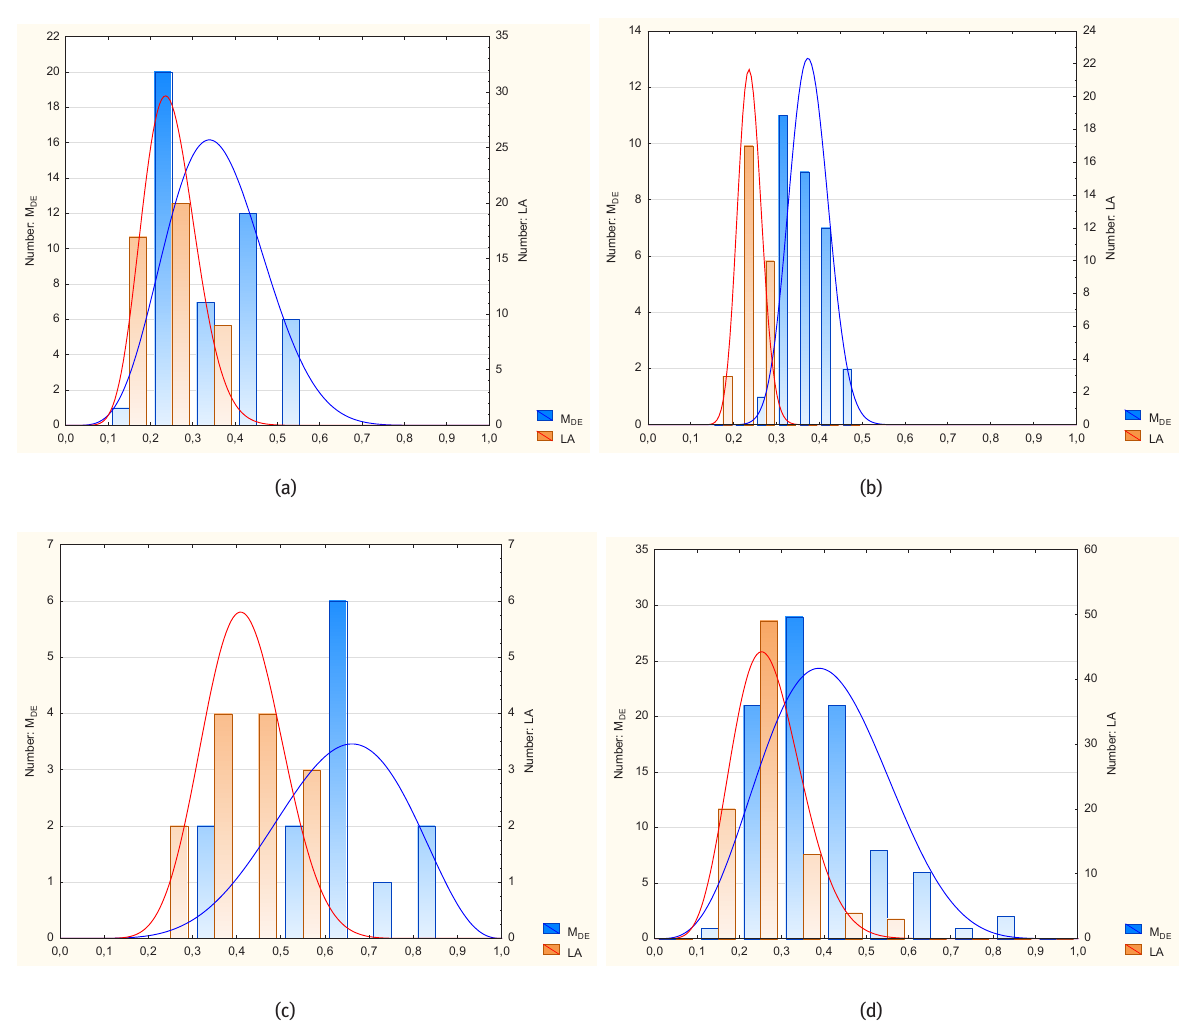
Figure 6: Histogram of beta distribution of resistance to fragmentation and abrasion: (a) Magura sandstone, (b) Cergos sandstone, (c) Krosno sandstone and (d) overall. coefficients for Carpathian sandstone aggregates. Table 2: Statistical values of LA and M DE Value LA coefficient M DE